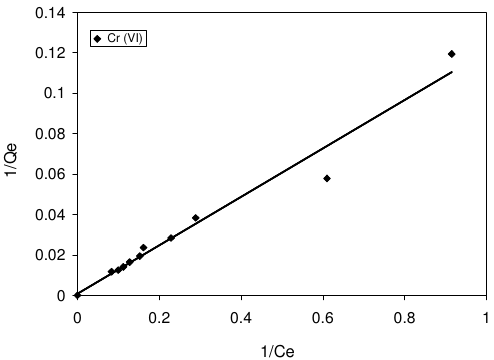
Figure 9 . Langmuir isotherm for adsorption of Cr(VI) on trametes versicolor polyporous